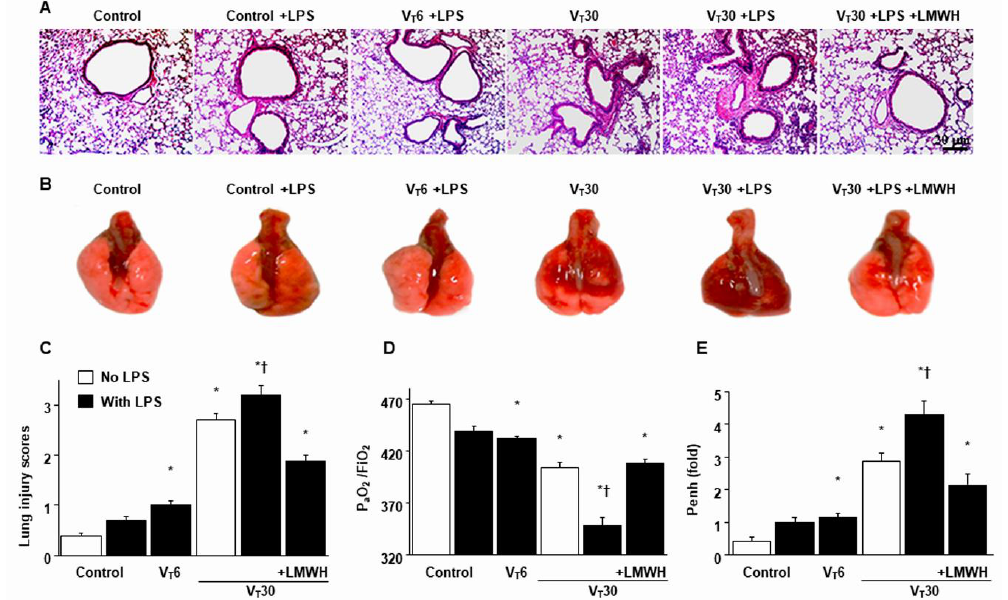
Figure 1. Suppression of endotoxin-augmented lung stretch-induced lung damage, hypoxemia and impaired respiratory function by enoxaparin ( A ) Histological examination (100×), ( B ) gross pathologic findings, ( C ) lung injury scores, ( D ) PaO 2 /FiO 2 and ( E ) enhanced pause from the same animals were from the lungs of nonventilated control mice and those subjected to a tidal volume of 6 mL/kg (V T 6) or 30 mL/kg (V T 30) for 5 h with or without LPS administration ( n = 5 per group). Enoxaparin, 4 mg/kg, was given subcutaneously 30 min before mechanical ventilation. Scale bars represent 20 µ m. * p < 0.05 versus the nonventilated control mice with LPS; † p < 0.05 versus all other groups. FiO 2 = fraction of inspired oxygen; LPS = lipopolysaccharide; LMWH = low-molecular-weight heparin; PaO 2 = partial pressure of oxygen; Penh = enhanced